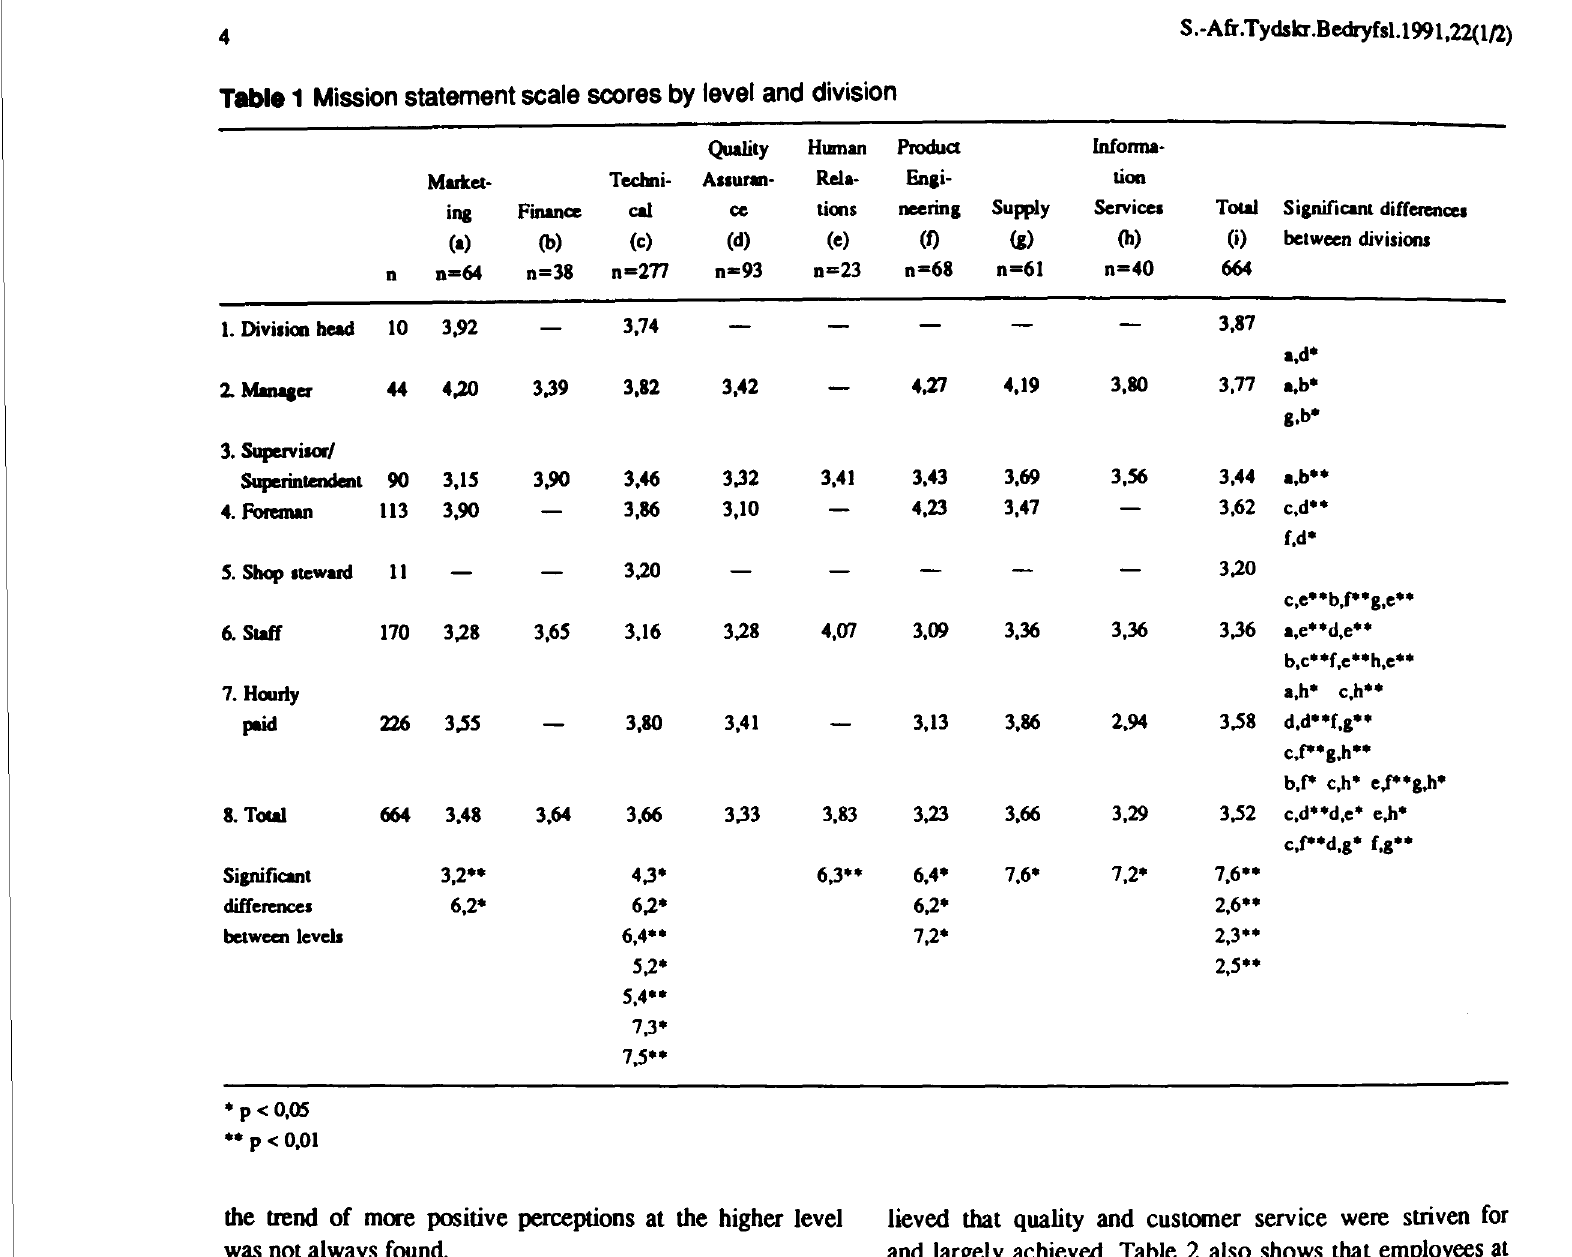
Table 1 Mission statement scale scores by level and division Quality Human Madcet· Tecbni- Assurm- Supply